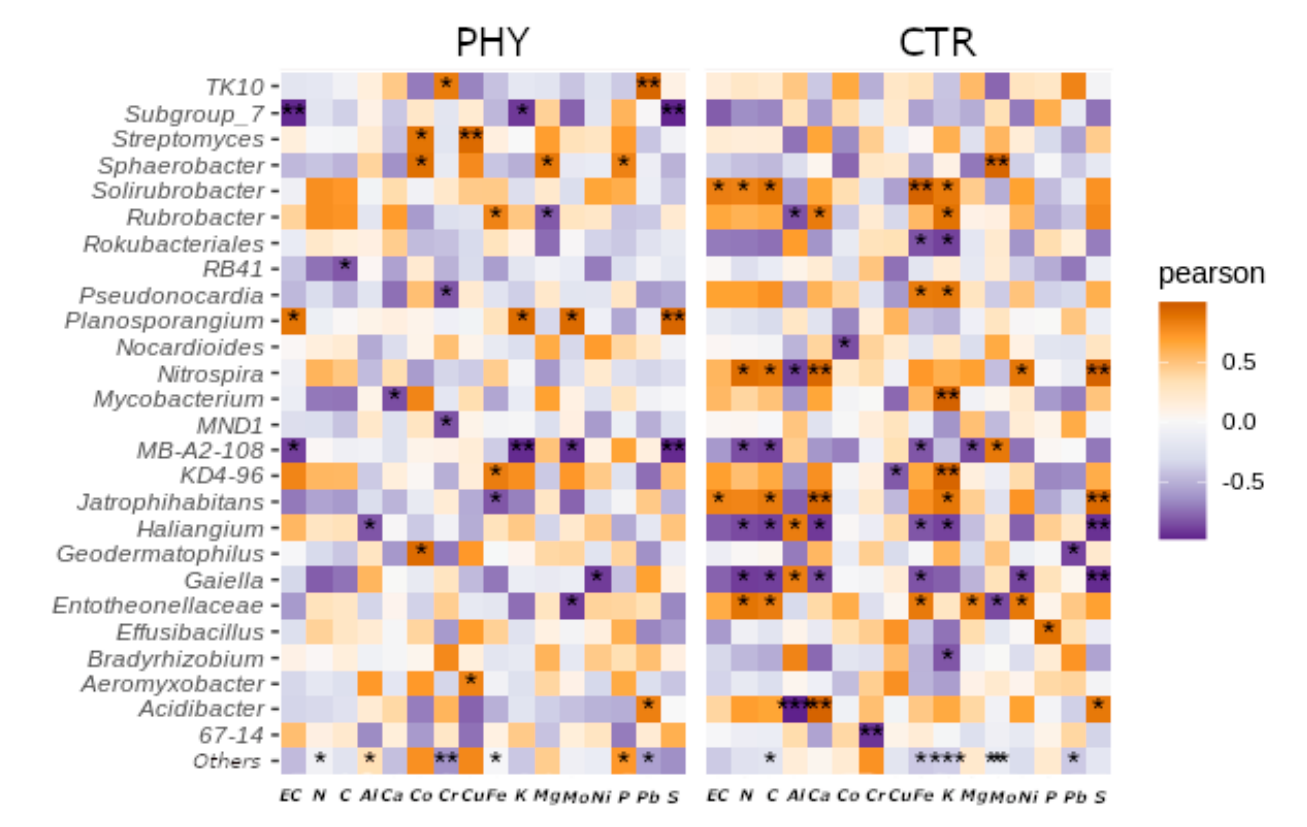
Figure 6. Genus abundance and soil parameter correlation heatmap. * = p < 0.05; ** = p < 0.01; *** = p < 0.001.